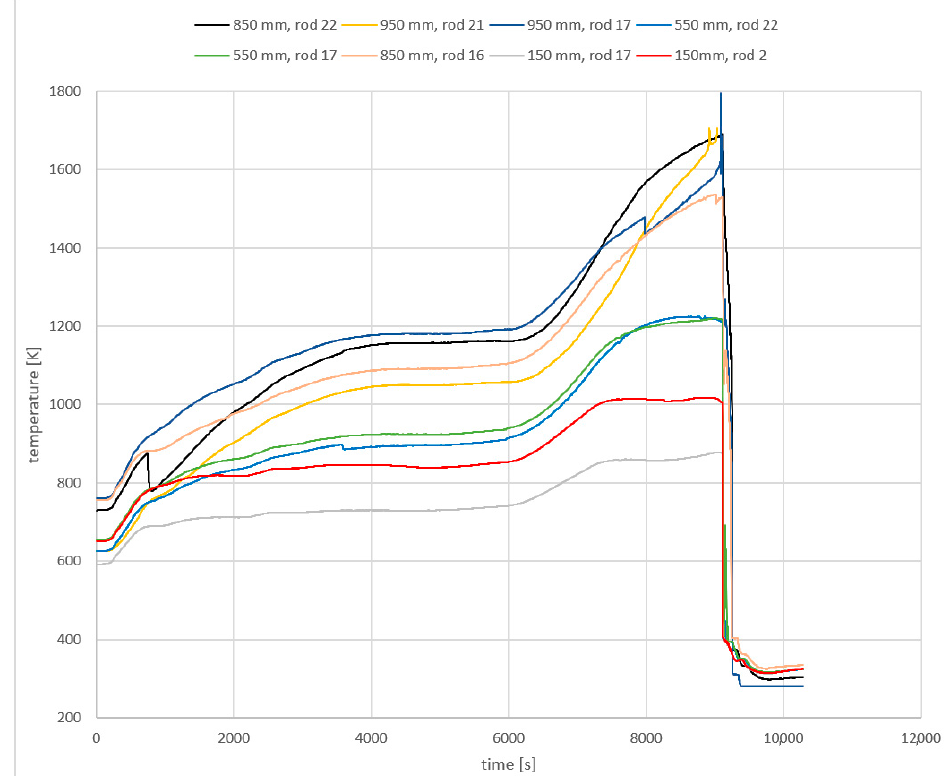
Figure 11. Temperatures measured in the heated part of the bundle and the peripheral ring (axial level, rod) [12].